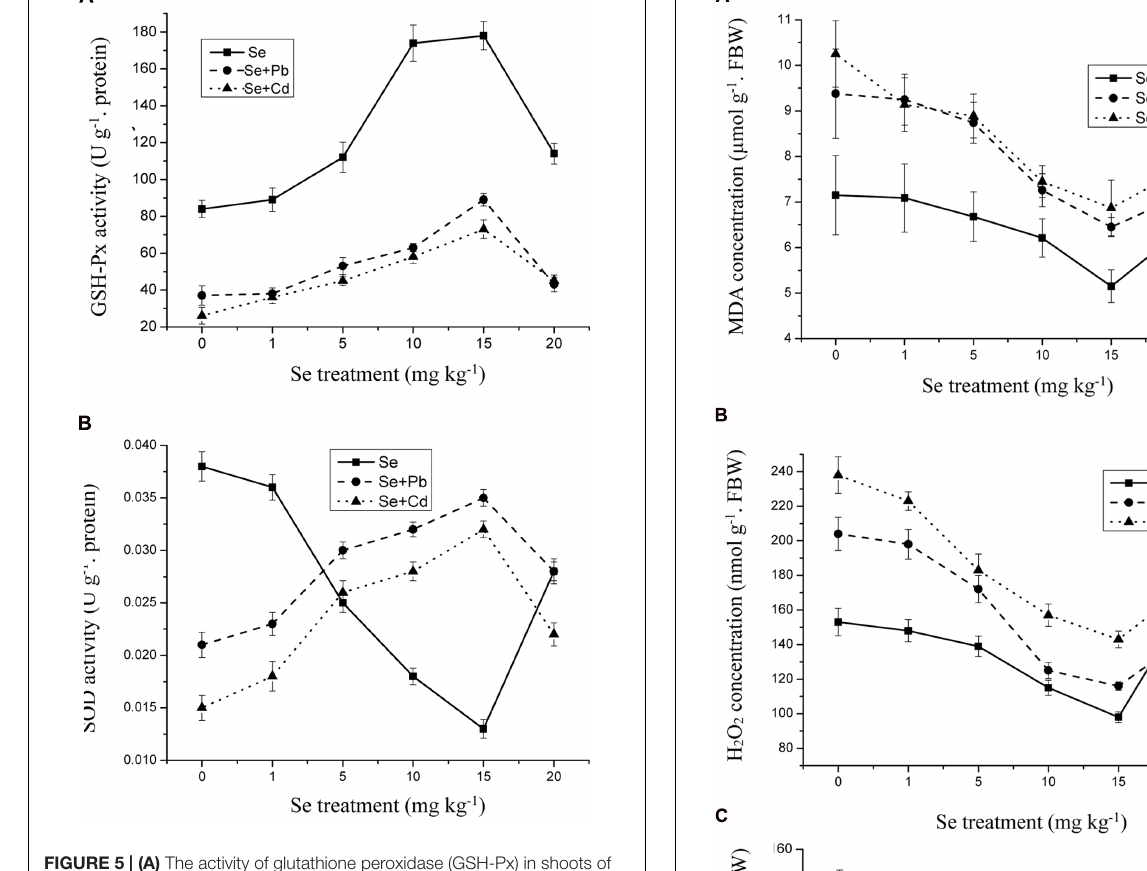
FIGURE 5 | (A) The activity of glutathione peroxidase (GSH-Px) in shoots of oilseed rape treated with soil Se, Se + 5Cd, or Se + 500Pb after a planting time of 60 days. (B) The activity of superoxide dismutase (SOD) in shoots of oilseed rape treated with soil Se, Se + 5Cd, or Se + 500Pb after a planting time of 60 days. Average values (Fresh biomass weight, FBW) provided with error bars representing the standard error. ( p ≤ 0.05).